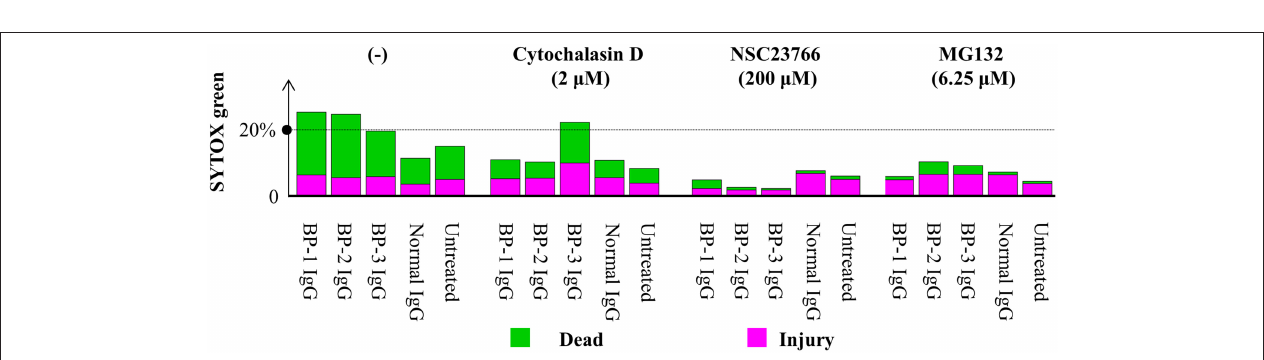
FIGURE 10 | Effects of cytochalasin D, NSC237766, and MG132 on the BP IgG-induced decrease in the number of adherent cells. NHEKs were pretreated with cytochalasin D (20 µ M) for 30min, NSC23766 (500 µ M) for 1h, or MG132 (12.5 µ M) for 0h, and then 2 mg/ml BP IgGs (BP-1, BP-2, and BP-3) or normal IgG were added to the cultured cells. Total numbers of adherent cells after the incubation with BP IgGs or normal IgG were counted every hour in a × 20 area (0.57 mm 2 ) for up to 6h. One-way ANOVA was used for the statistical analysis. * p -value < 0.05.